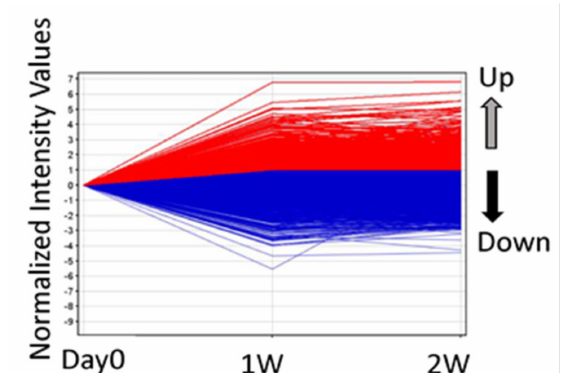
Figure 1. Differences in gene expression profile between 1 week (W) and 2 W groups after extracap- sular clear-lens extraction (ECLE). Scatter plots were used to distinguish the differentially expressed mRNA. Red and blue indicate high and low expression, respectively.